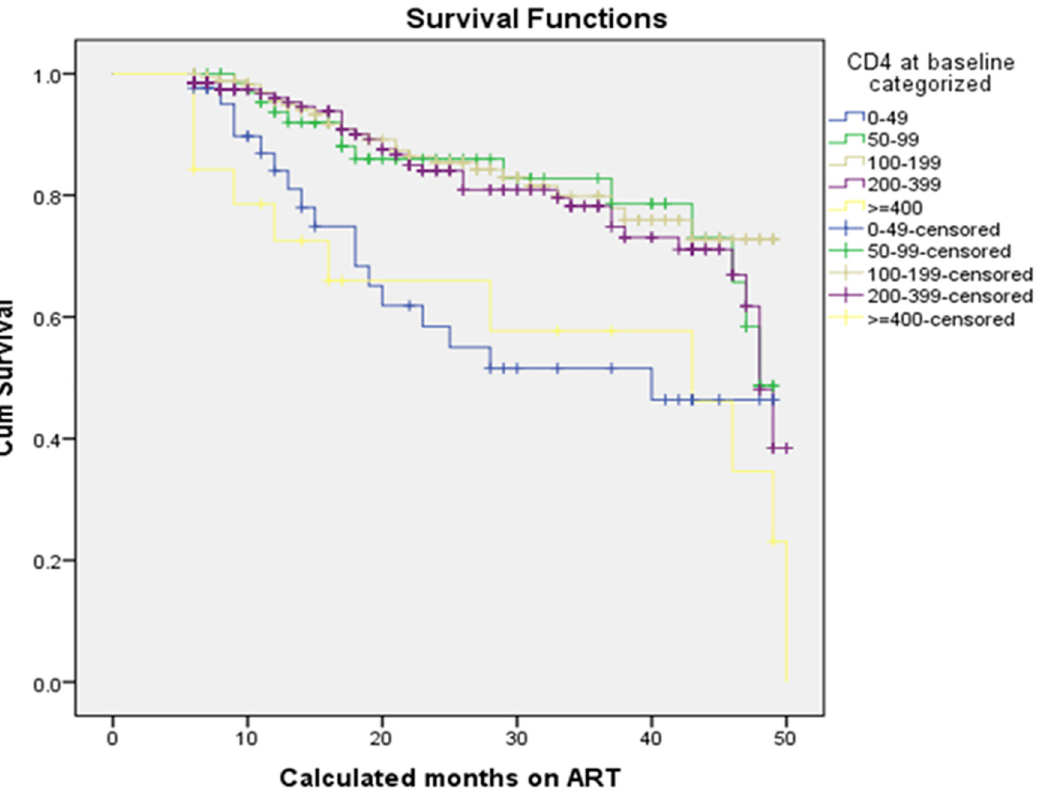
Fig 2. Survival functions of different groups of CD4 at baseline of ART patients in private health facilities in Addis Ababa, 2009 – 2013.